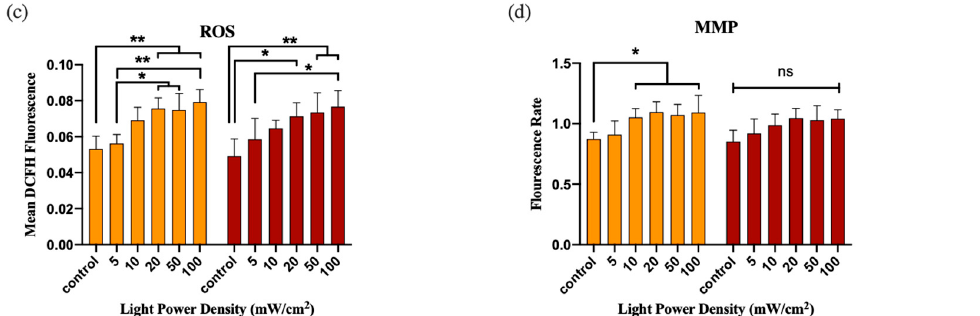
Figure 8. Comparison between CW light with different light power densities and fixed fluences: ( a ) cell viability, ( b ) ATP, ( c ) ROS, and ( d ) MMP. * p < 0.05 and ** p < 0.01. ns: not significant